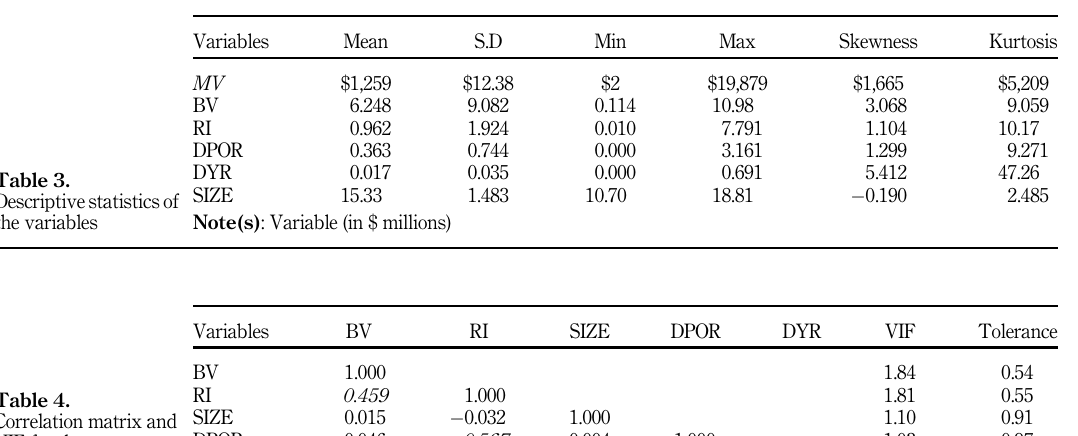
VIF for the independent